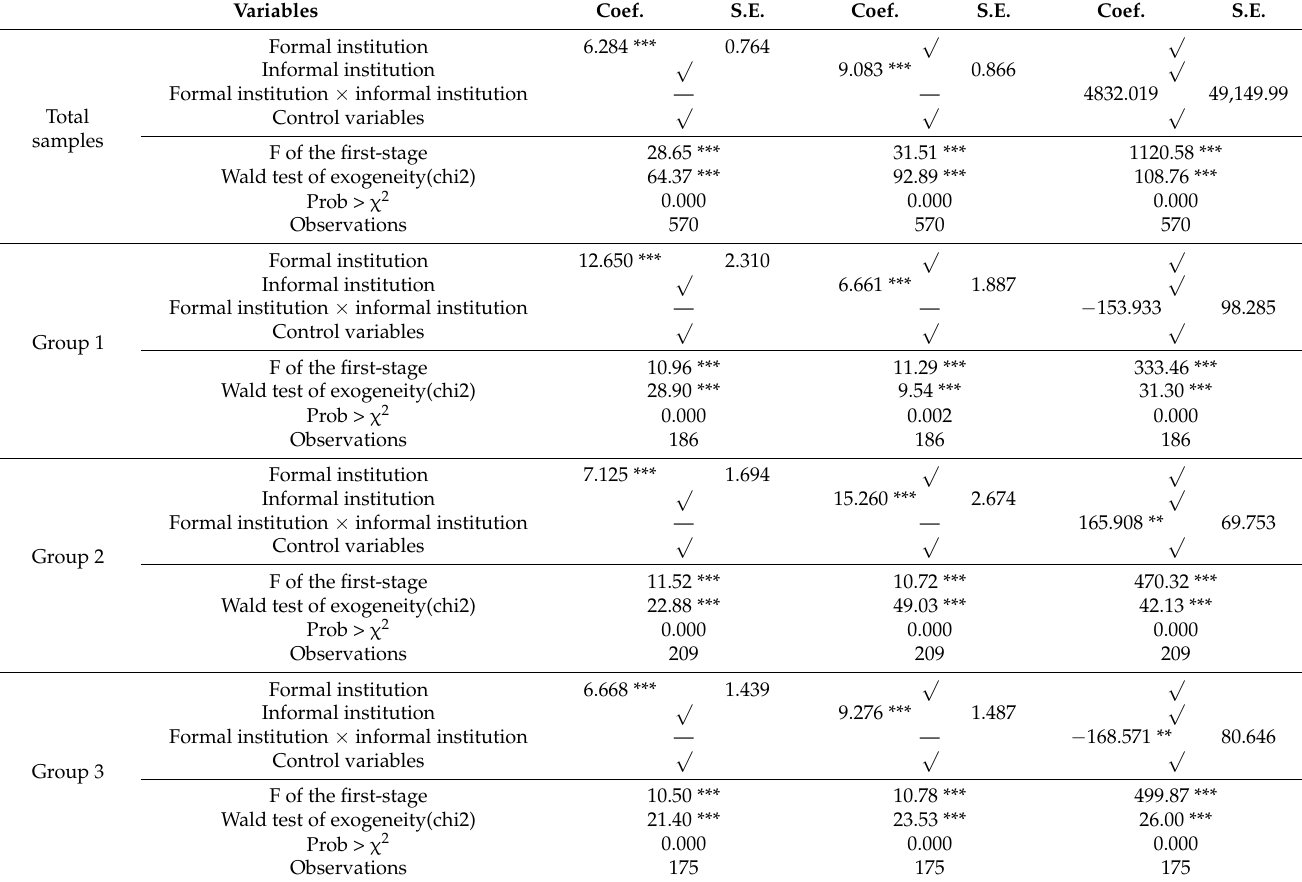
Table 6. Results of the endogenous test (ivprobit